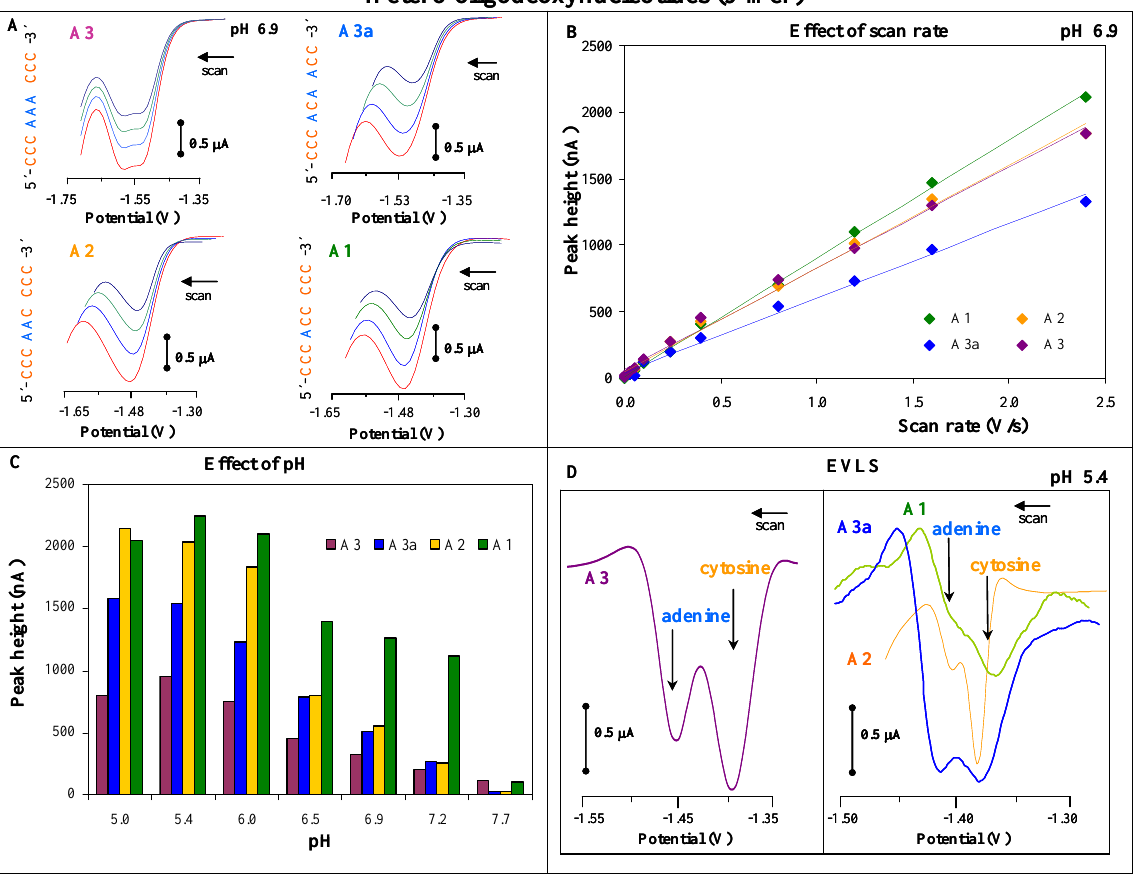
Figure 3. Analysis of hetero-oligodeoxynucleotides (9-mers): A3, A3a, A2 and A1. A ) Voltammograms of ODNs (1 µ M) in the presence of 0.3 M ammonium formate and 0.05 M phosphate buffer (pH 6.9) at different scan rates (200, 400, 800, and 1 600 mV/s). B ) Dependence of ODNs current responses on scan rate. C ) Influence of pH (0.1 M phosphate buffer) on heights of ODNs signals. D ) Elimination voltammograms of ODNs suitable for the function eliminating kinetic and charging currents, and conserving the diffusion current (reference scan rate of 800 mV/s, pH 5.4)